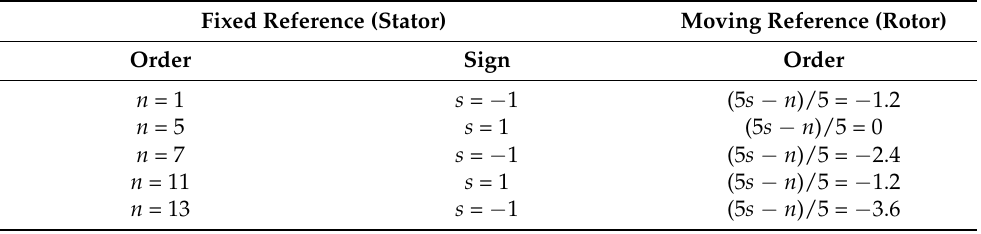
Table 5. Flux density harmonics created by the armature referenced to the stator and to the rotor in the Qs36p15